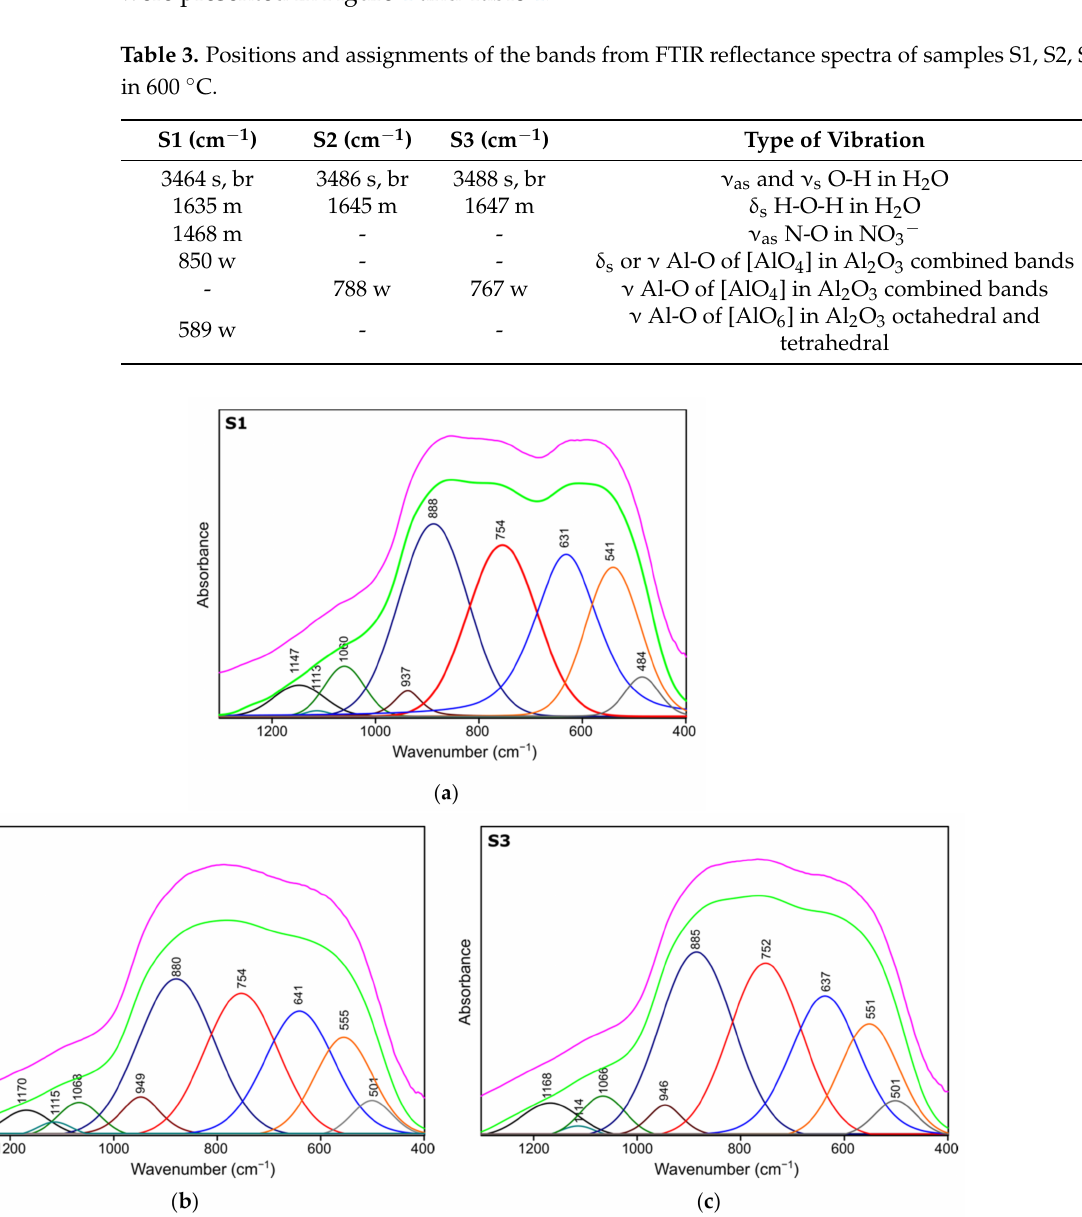
Figure 4. Spectra deconvolution of the samples ( a ) S1, ( b ) S2, ( c )